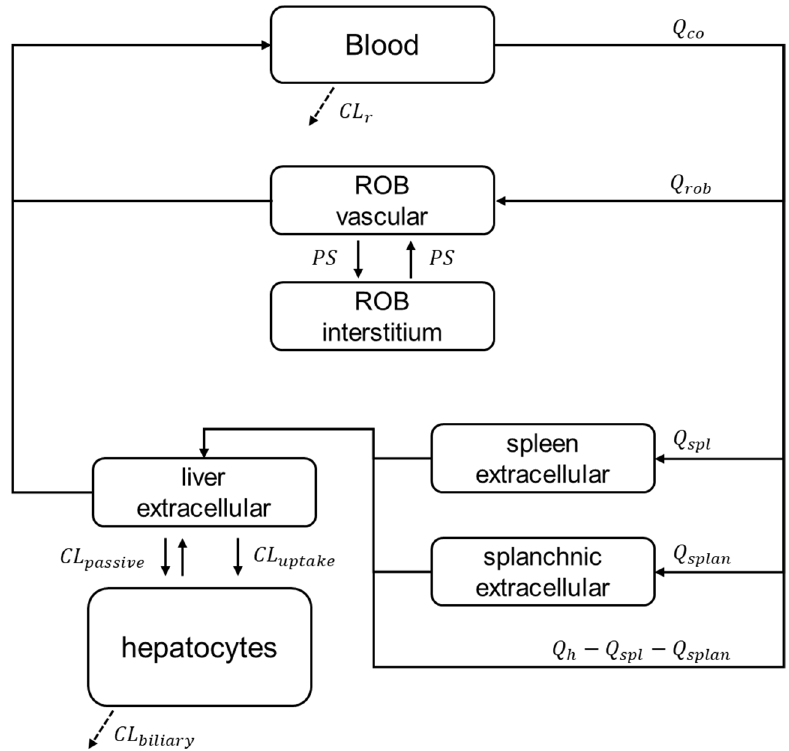
Figure 1. Structure of the reduced gadoxetate PBPK model. Continuous arrows represent the mass exchange within the system, while dashed arrows represent gadoxetate elimination. Subscripts co, rob, spl, splan, h, and r, represent cardiac output, rest of the body, spleen, splanchnic organs, hepatic and renal, respectively. CL, Q, and PS, represent the clearance processes, the blood flows, and the permeability surface product, respectively. Reproduced from [23] under CC-BY license.